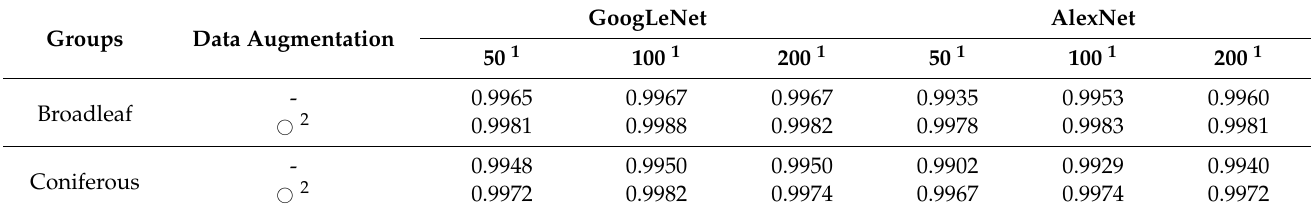
Table 2. F-scores as the classification accuracy of tree species for test data when classifying between groups of either broadleaf or coniferous